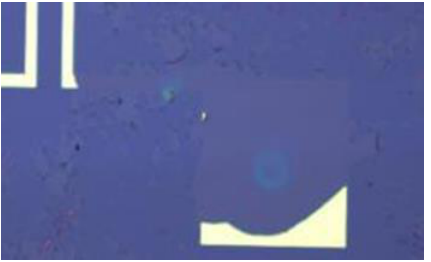
Figure 2. Metal shedding occurs when the graphene acts as a “stripping adhesive”.